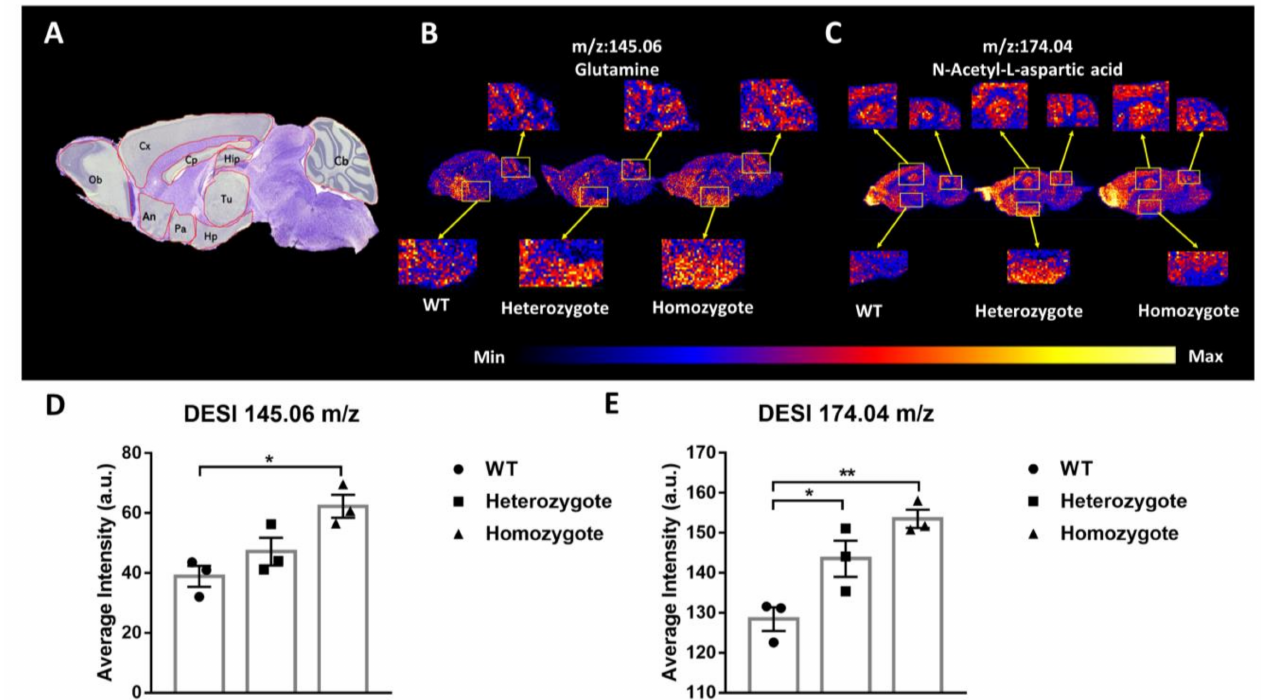
Figure 9. BChE KO increased glutamine and N-acetyl-L-aspartic acid levels in the brain of 10-month-old mice. ( A ) Sagittal section of the brain. Cb, cerebellum; Cx, cerebral cortex; Hip, hippocampus; Cp, corpus callosum; Tu, thalamus; Hp, hypothalamus; Pa, preoptic area; An, nucleus accumbens and Ob, olfactory bulb. ( B , C ) Representative images from DESI-MS. The m / z 145.06 represents L-glutamine, and the m / z 174.04 represents the N-acetyl-L-aspartic. ( D ) Average intensity (a.u.) of L-glutamine in the Hp and Cb. ( E ) Average intensity (a.u.) of N-acetyl-L-aspartic acid in the Hip, Hp, CX, and Cb. Data were shown as mean ± SEM. n = 3 mice per group. * p < 0.05; ** p < 0.01; vs. WT group, one-way ANOVA followed by Tukey’s post hoc test (for D , E